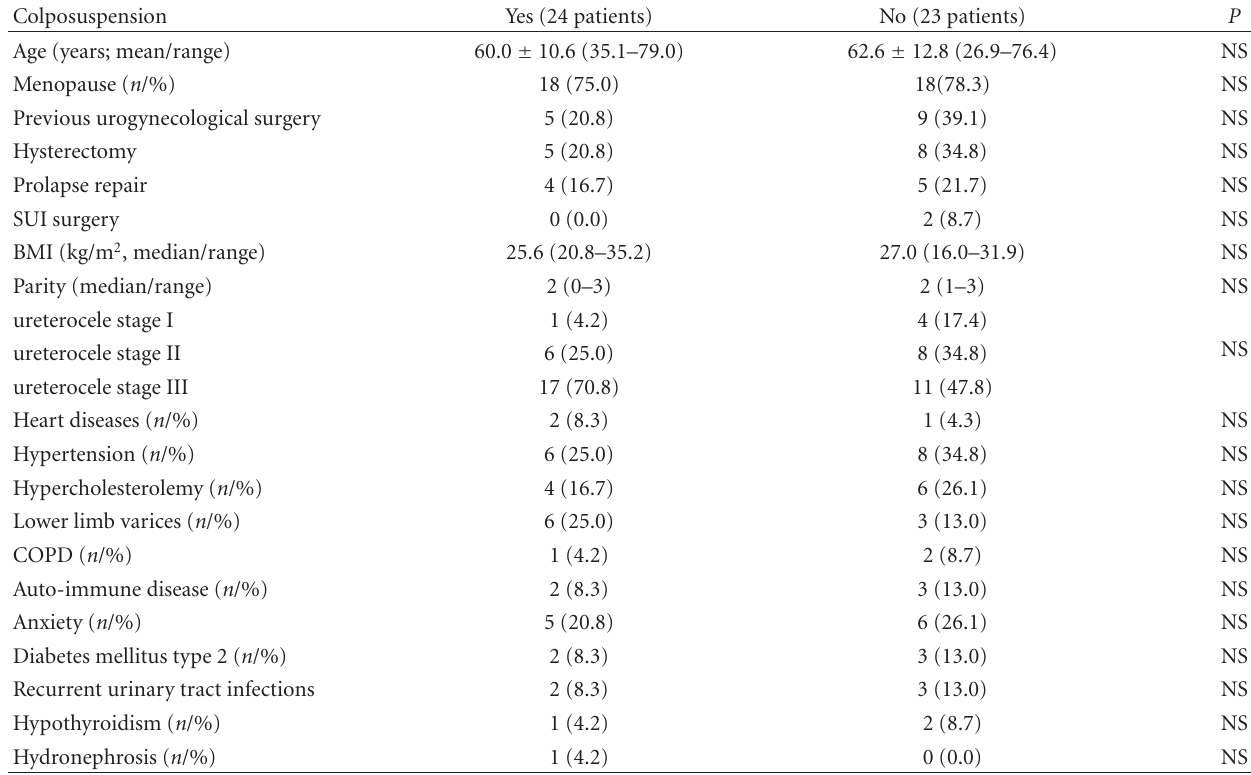
Table 1: Demographic and clinical variables of groups A and B. Patient